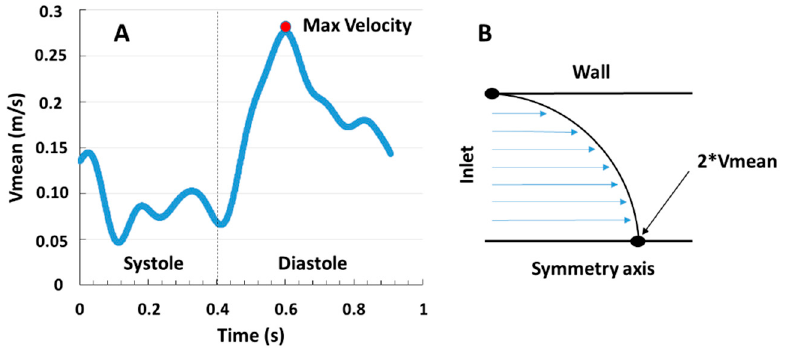
Figure 2. ( A ) Physiological velocity waveform adapted from Davies et al. (2006) and ( B ) Velocity profile imposed at the